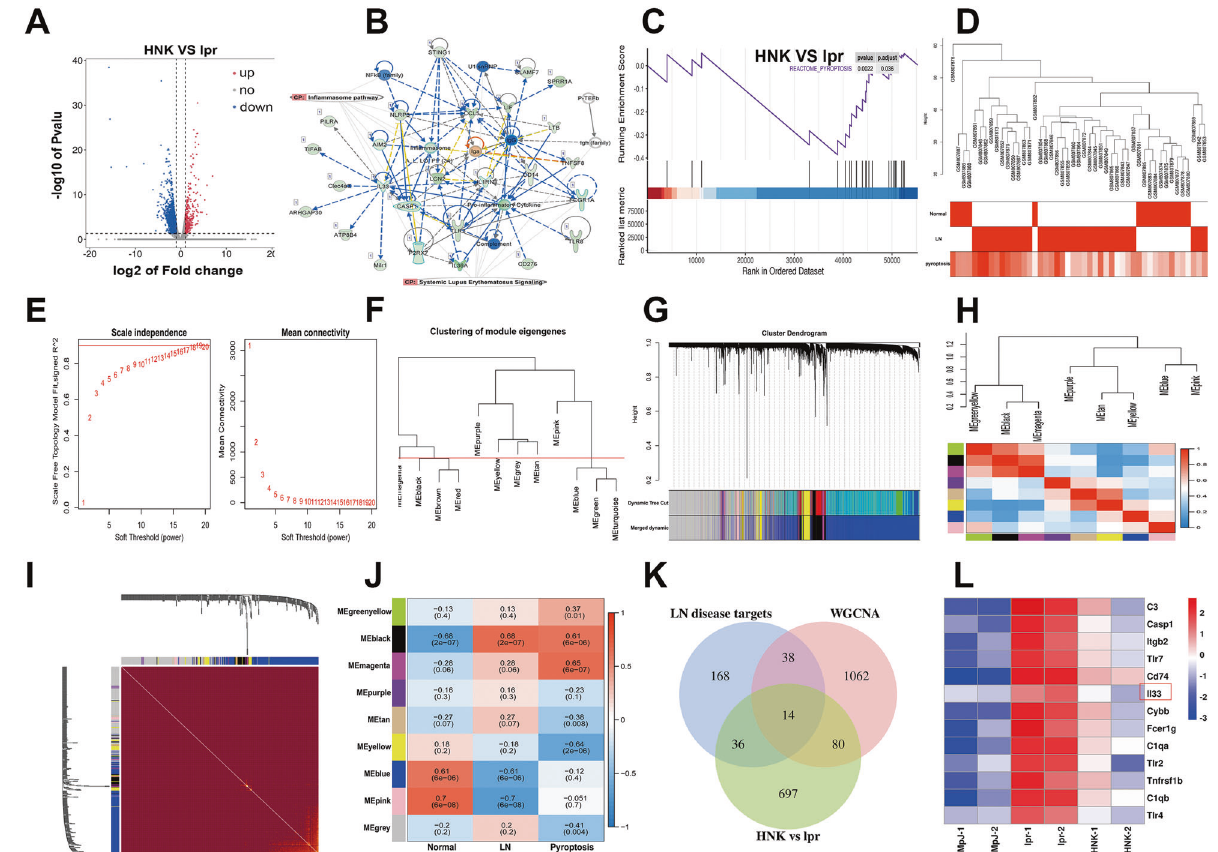
Fig. 2 Changes in the overall gene-expression pro fi les after treatment with Honokiol (HNK). A Volcano plot illustrating the differentially expressed genes between HNK and lpr groups. B Gene interaction network after HNK intervention, based on ingenuity pathway analysis. C Gene set enrichment analysis of the HNK-induced differentially expressed genes related to the pyroptosis pathway. D Sample dendrogram and trait heatmap. E Scale-free topology model fi t index and mean connectivity under various soft thresholds power, The cut-off soft threshold β was set as 0.9 and β = 15 was selected. F Clustering of module eigengenes with a shear height of 0.25. G Cluster dendrogram, showing the original modules and the combined modules. H Eigengene dendrogram and Eigengene adjacency heatmap of various modules. I Network heatmap plot of the co-expression modules. J Heatmap of the module-trait relationships. K , L A potential disease target of HNK ameliorates lupus nephritis